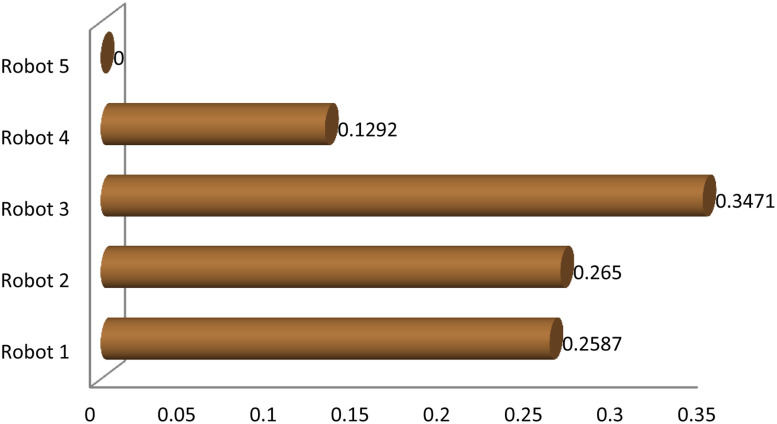
Sensitivity analysis of the criteria C1.